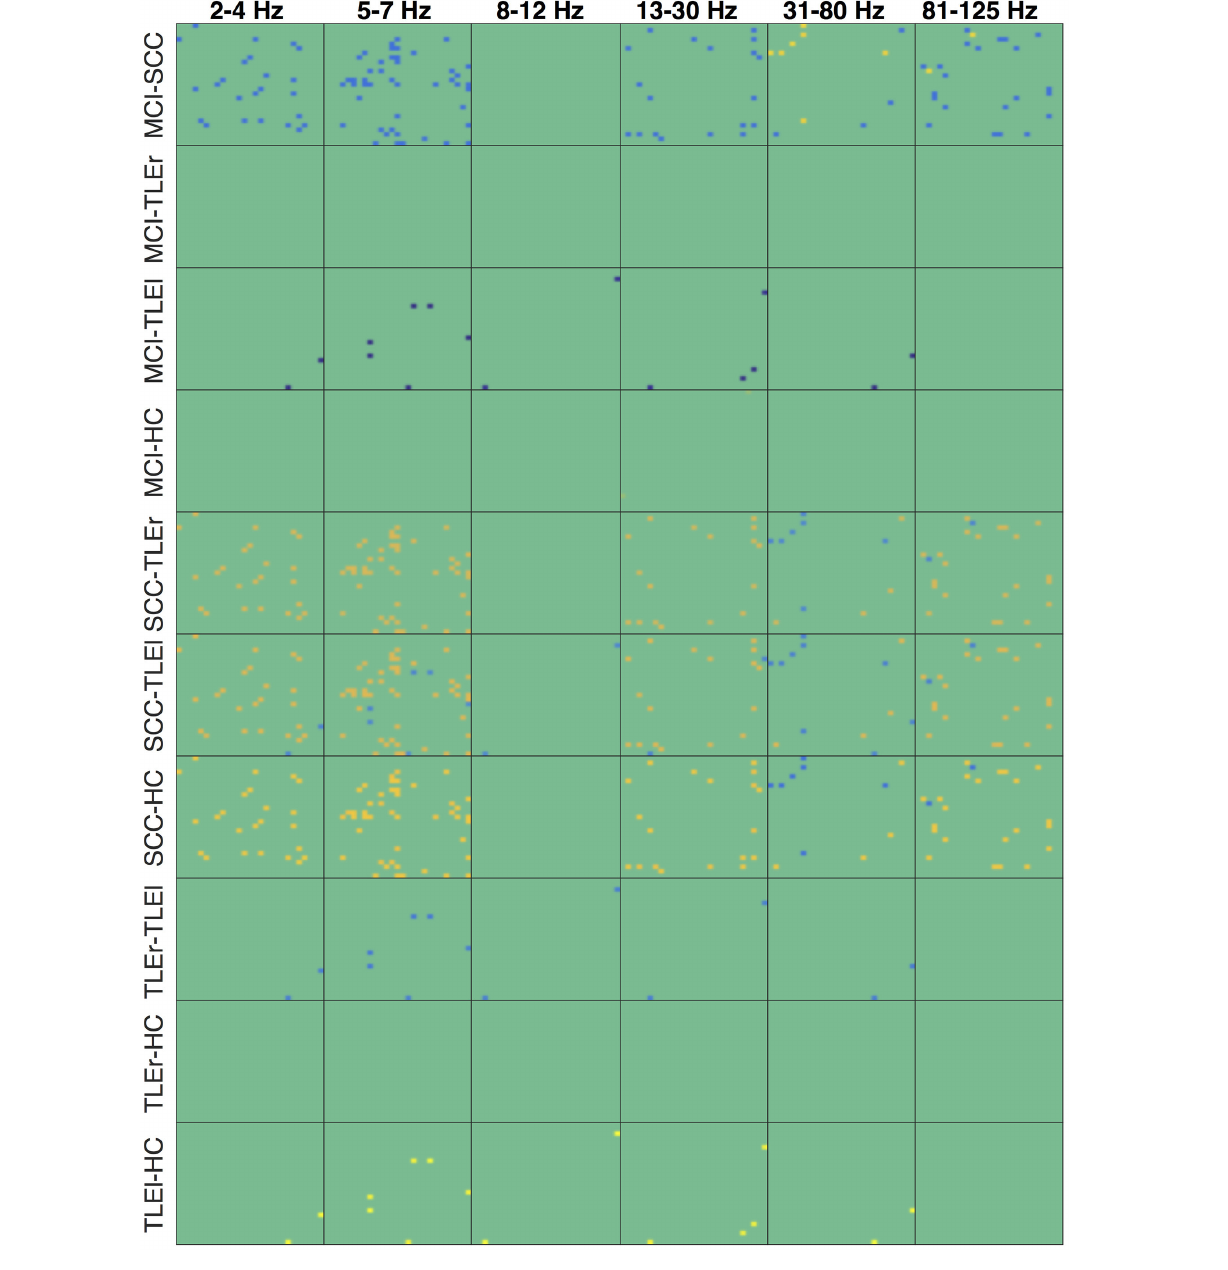
FIGURE 7 | Heatmaps of group differences of the reliability for spectrum. Heatmaps show the reliability of all electrode × electrode interactions for measure of interaction spectrum, sorted by group comparisons in rows and frequency in columns. Each of the small boxes is drawn as the network matrix with one point corresponding to a specific electrode × electrode combination. Colors indicate values from − 37.45 (dark blue) to + 32.85 (bright yellow). Not-significant differences were set to 0 and appear in green. Electrodes start from top left following the order of the list as given in Section 2.4. MCI, mild cognitive impairment; SCC, subjective cognitive complaints; TLEr, right lateralized temporal lobe epilepsy; TLEl, left lateralized temporal lobe epilepsy; HC, healthy